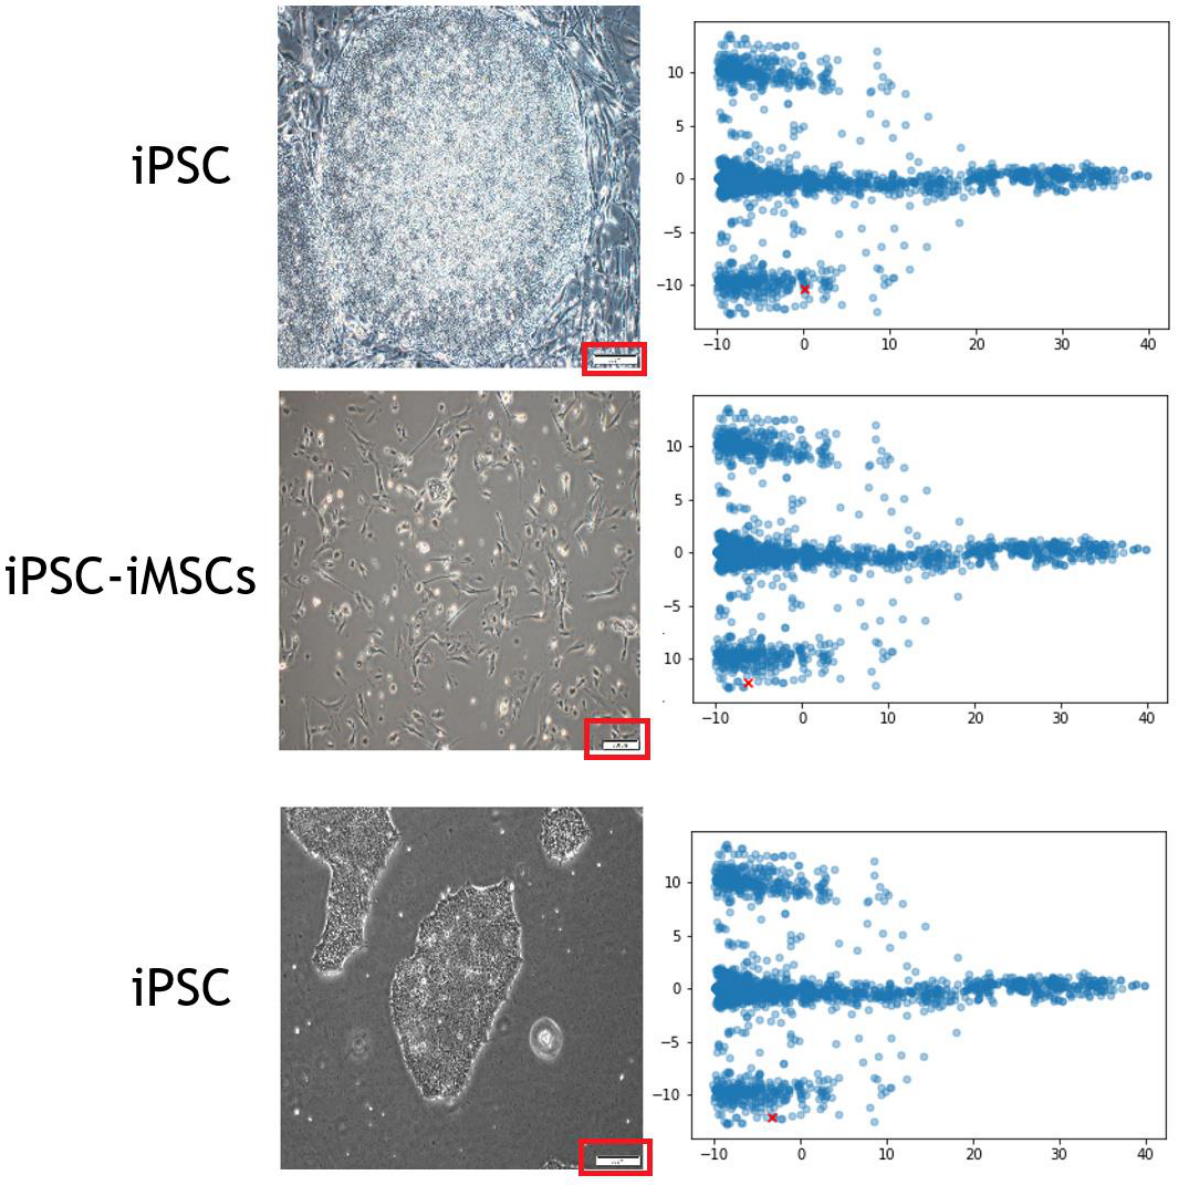
Figure 5. A representative image interpretation by our proposed model. The cell images (left side) with scale bars (red rectangle) were subjected to the training of our proposed model. When using PCA to reduce the dimension (right side), the scale bars can be detected in the feature coordination (red cross